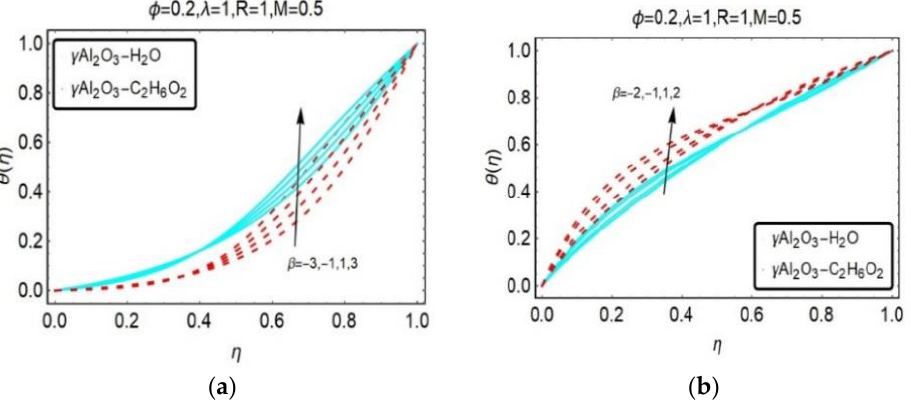
Figure 16. Influence of 𝑅 on 𝜃(𝜂) for ( a ) 𝑆 > 0 and ( b ) 𝑆 < 0 .